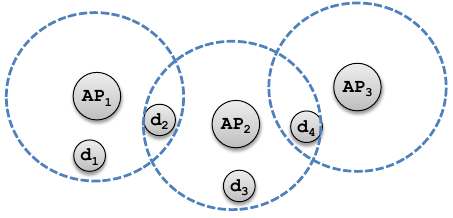
Figure 1. An instance of APs and user